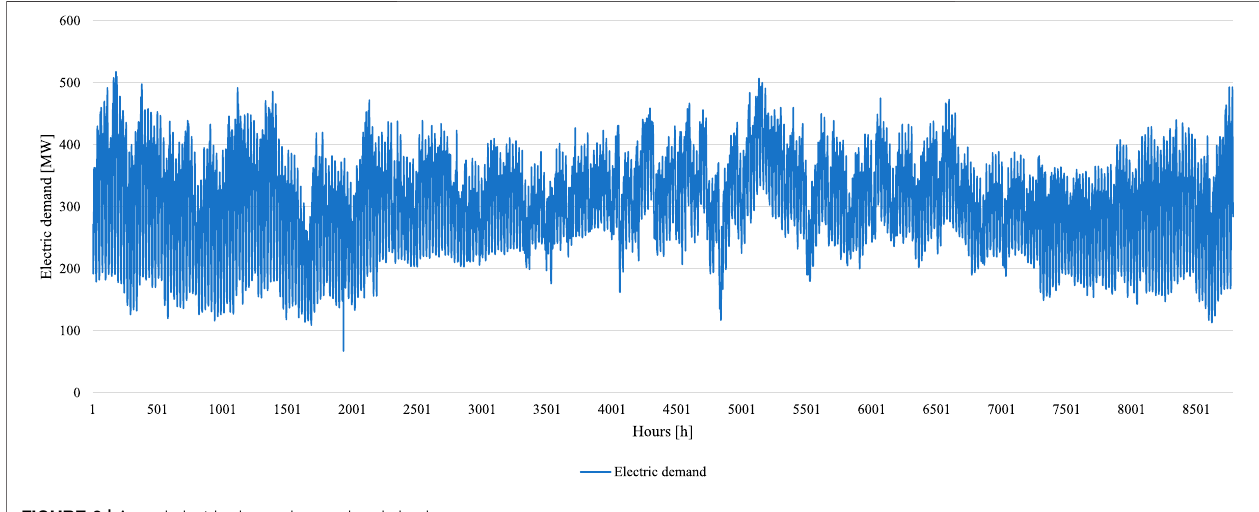
FIGURE 3 | Annual electric demand on an hourly